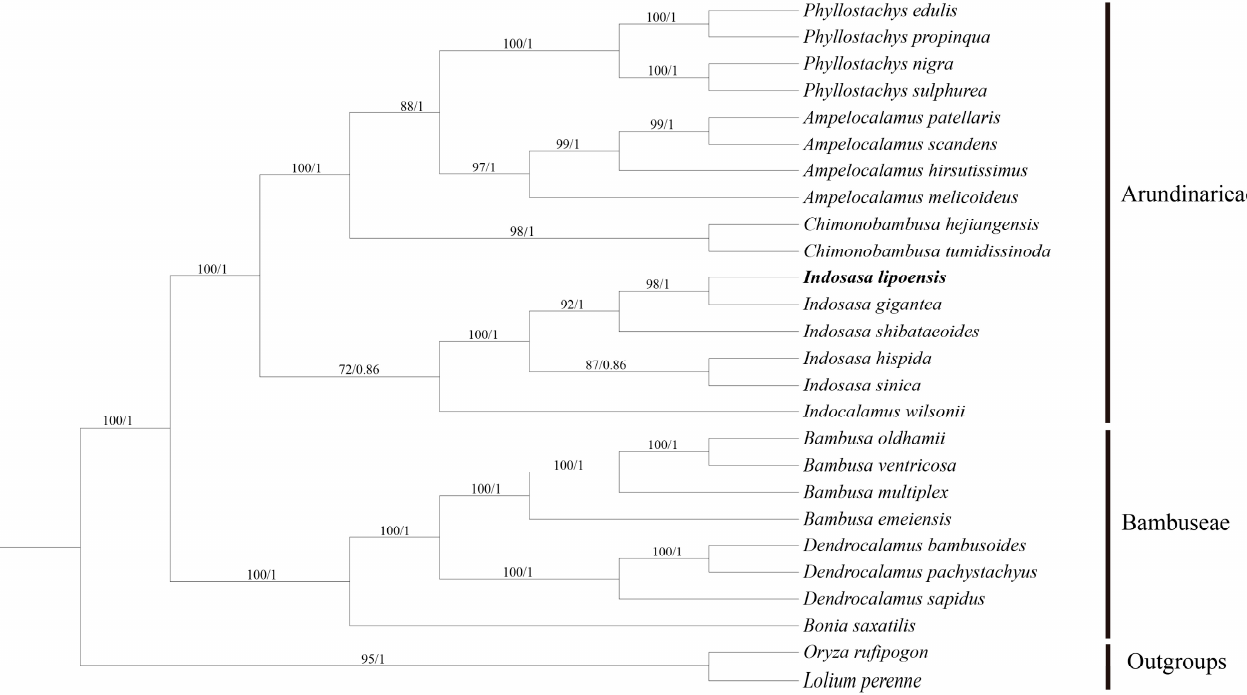
Figure 8. The maximum likelihood (ML)- and Bayesian Inference (BI)-constructed phylogenetic tree of the cp genomes of 24 Bambooaceae species. Oryza rufipogon and Lolium peremne were employed as outgroups.